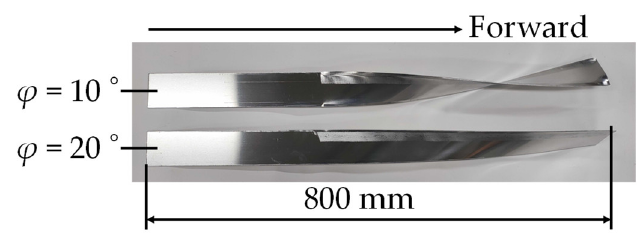
Figure 14. Effect of skew angle on appearance of the rolled sheet metal. Table 7. Average specific twisted angle   ( δ = 20 mm, t = 2 mm). Unit: °/mm Table 7. Average specific twisted angle β ( δ = 20 mm, t = 2 mm). Unit: